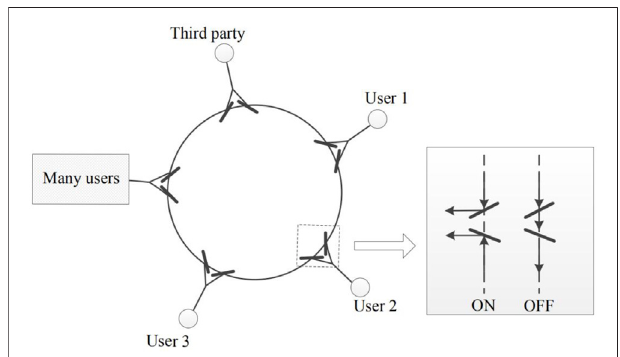
FIGURE 1 | An optical-ring quantum communication network. The third party and users of the network are linked with their loop by the coupled fi bers. By the “ space optical switch ” , the photons can be received by the right